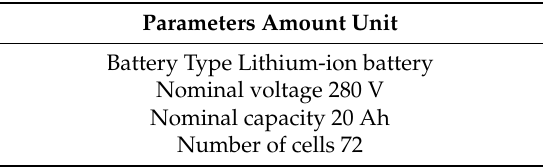
Table 3. Electrical parameters of the battery.